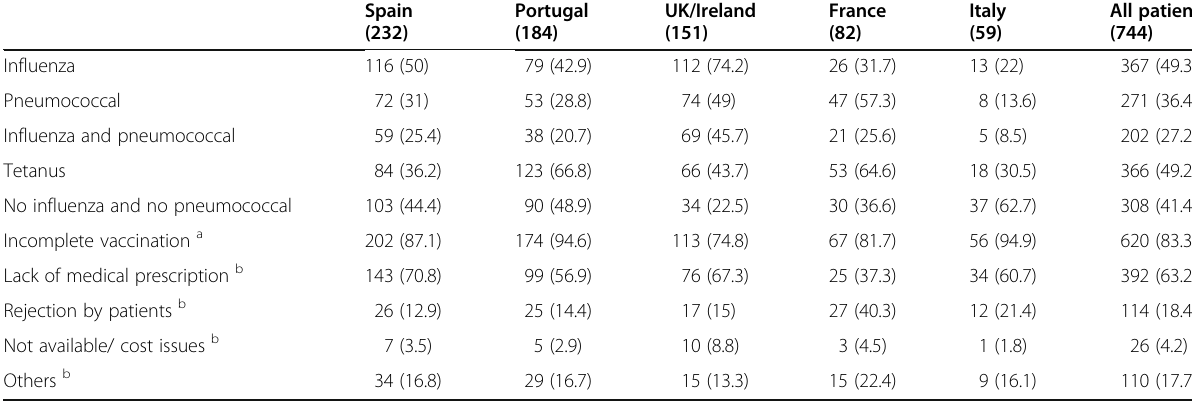
Table 4 Vaccine coverage and reasons for non-vaccination of European patients*